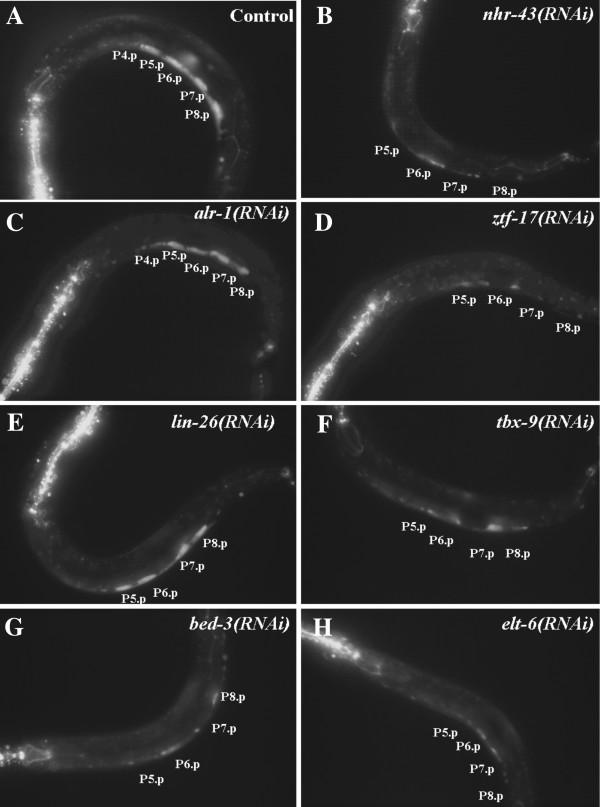
Seven transcription factors affect lin-39::GFP expression in the VPCs at early L3 stage. GFP expression in the VPCs P5.p - P8.p from smg-1; deIS4 (lin-39::GFP) animals treated for RNAi of individual transcription factors identified in yeast (panels B-H), or given control RNAi (empty vector; panel A). Early L3 stage animals are shown; anterior is left, ventral is down. These animals also express ajm-1::GFP, which outlines cell junctions of hypodermal cells and the pharynx (bright staining in the anterior seen in most panels). RNAi for lin-26, bed-3, and tbx-9 causes severe embryonic lethal and larva arrest phenotypes, so RNAi for these genes was performed by feeding newly-hatched L1 larvae on RNAi bacterial lawns and examining GFP expression in these same animals at the L3 stage. For all other genes, RNAi treatment was carried out on P0 animals, and their F1 progeny were examined as L3 animals. All pictures were taken under the same exposure.